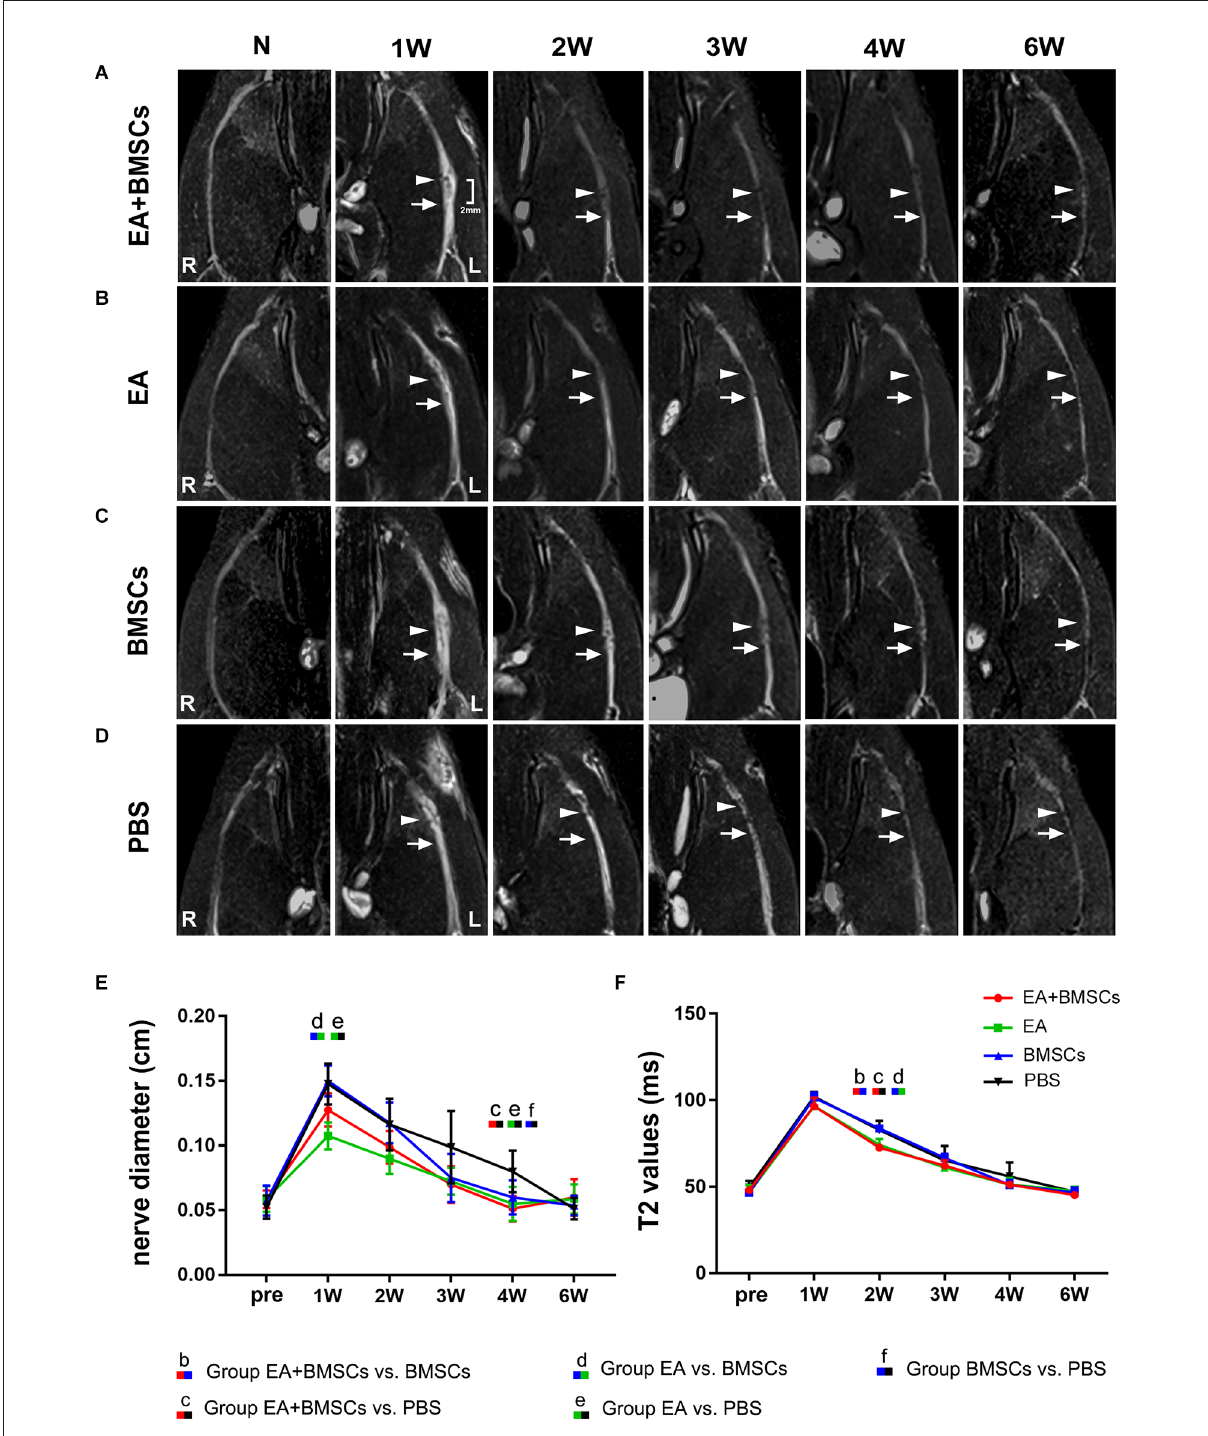
FIGURE2 Sequential FS-T2WI of injured and uninjured contralateral sciatic nerves in rats. (A–D) MRI images depicting the injured nerves on the left side of the EA + BMSCs, EA, BMSCs, and PBS subgroups and the uninjured nerves (control group) on the opposite side. Injured nerves in all subgroups exhibited enlarged and hyperintense signals in the proximal and distal portions, which decreased gradually. BMSCs were injected into the crushed section (indicated by arrowheads). R: right, L: left, W: week. (E) Nerve diameter in the distal stumps of the injured nerves of four subgroups up to 6 weeks post-surgery. (F) T2 values in the distal stumps of the injured nerves of four subgroups up to 6 weeks post-surgery. The nerve diameter andT2valuesofacquisitionpointswithingroupswerecomparedbyusingrepeated-measuresone-wayANOVAwithBonferroni post-hoc testing, and statistically significant differences are listed in Tables 1 , 2